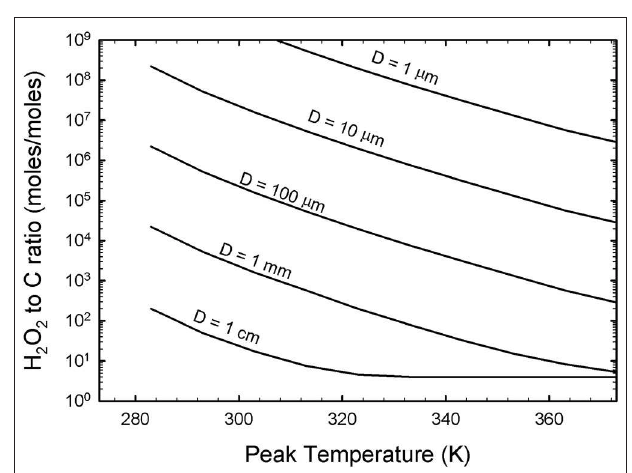
FIGURE 5 | The H 2 O 2 to C content on a mole per mole basis of a drop determines how likely it is to alter the organic inventory of a droplet